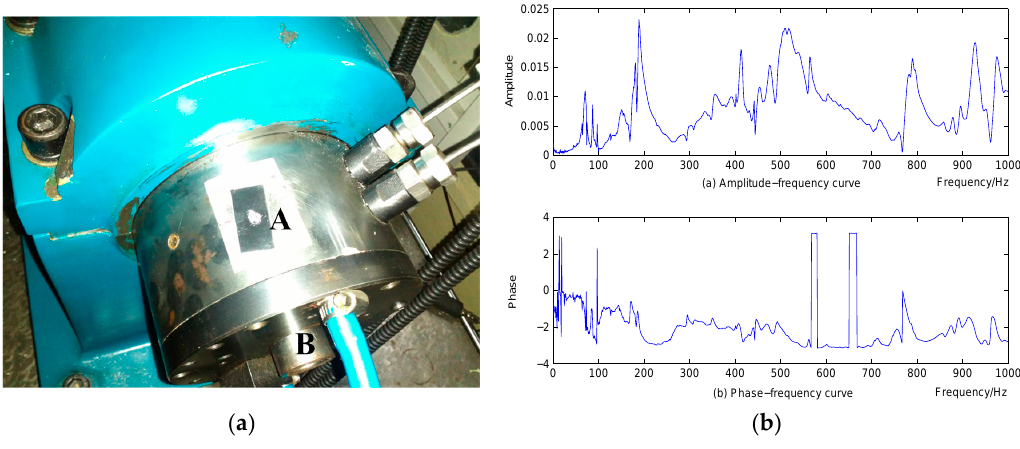
Figure 6. Spindle and tested FRF ( a ) spindle ( b ) FRF.